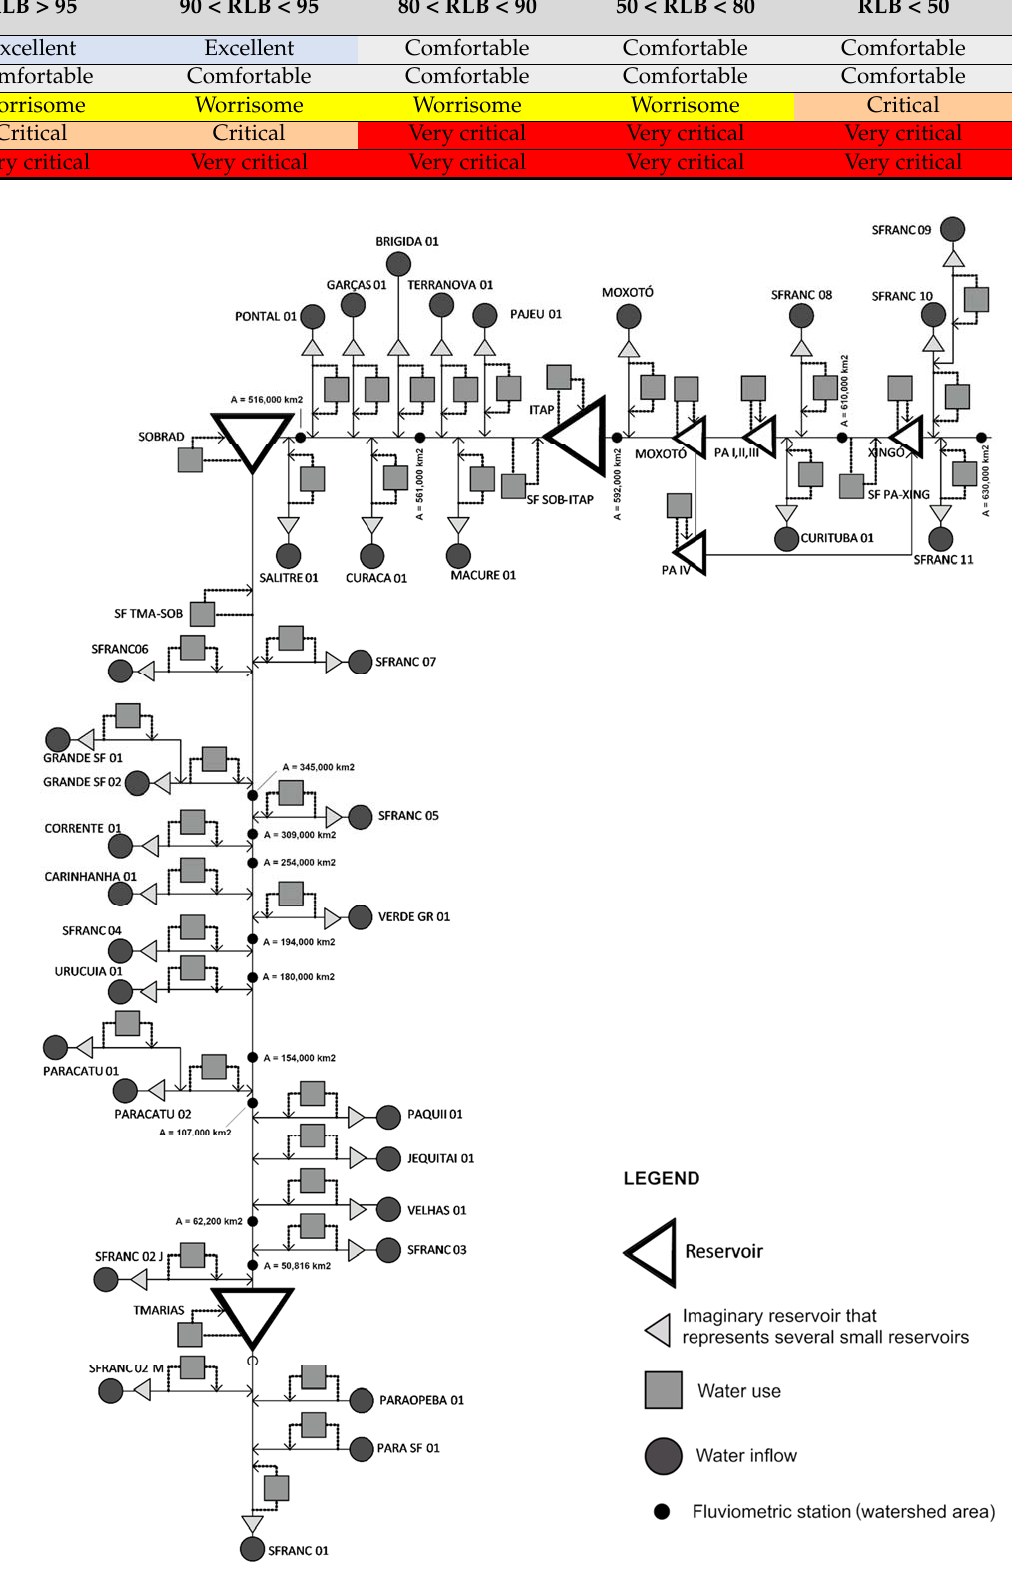
Figure 3. Conceptual scheme of the São Francisco River Basin. The water flows from south to north, into the Atlantic Ocean.